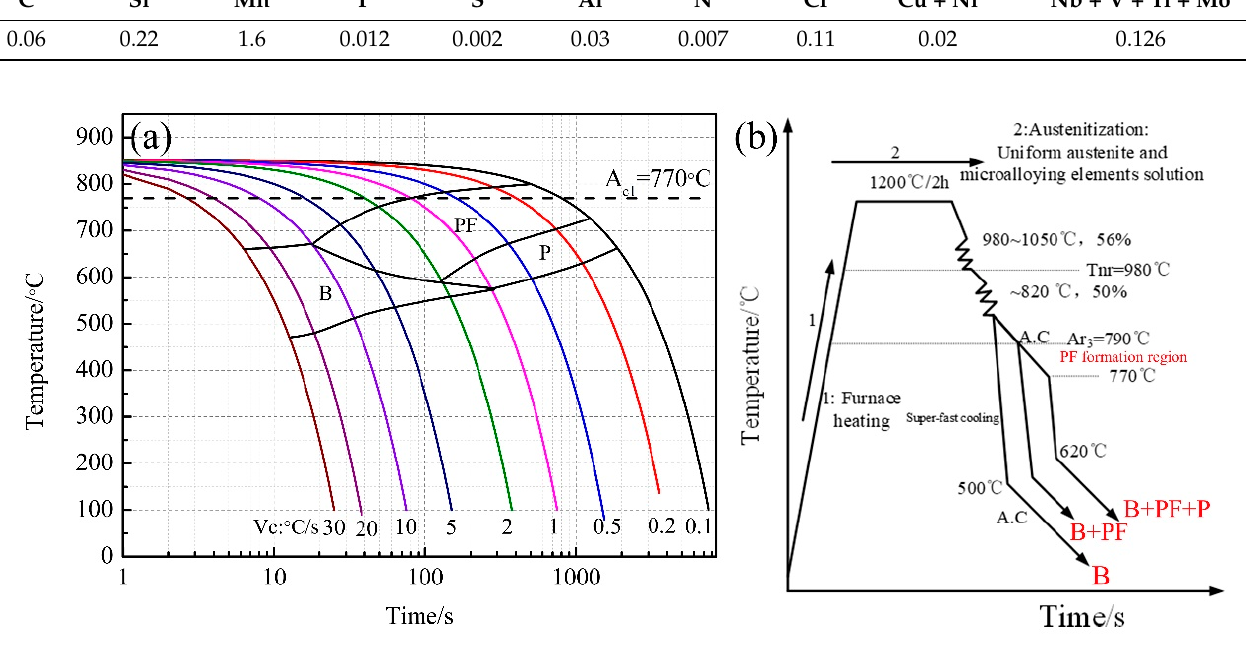
Figure 1. ( a ) DCCT curve, ( b ) Schematic of thermomechanical control process